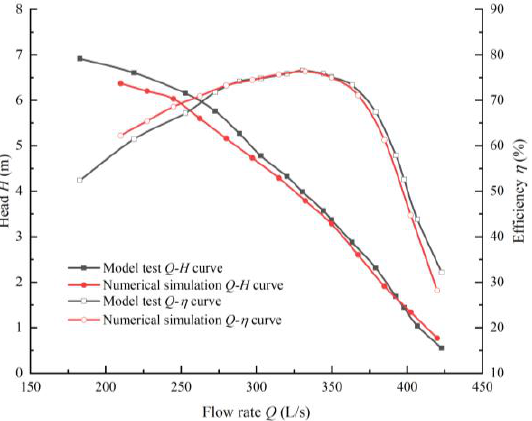
Figure 5. Comparison of external characteristics between numerical simulation and tests.